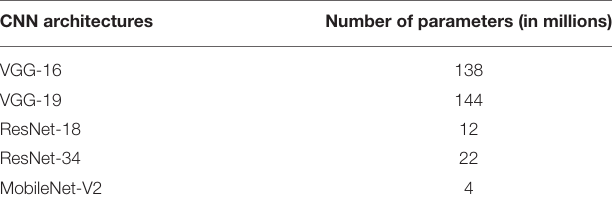
TABLE 2 | Number of parameters for the five deep CNN